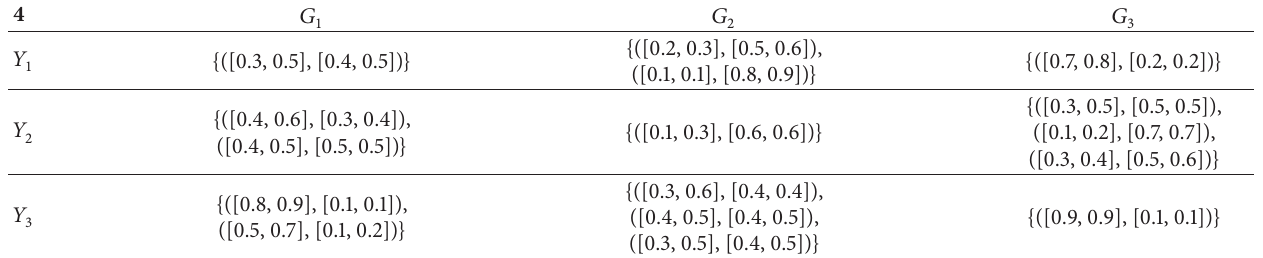
̃𝑅 (3) provided by 𝐷 3 .